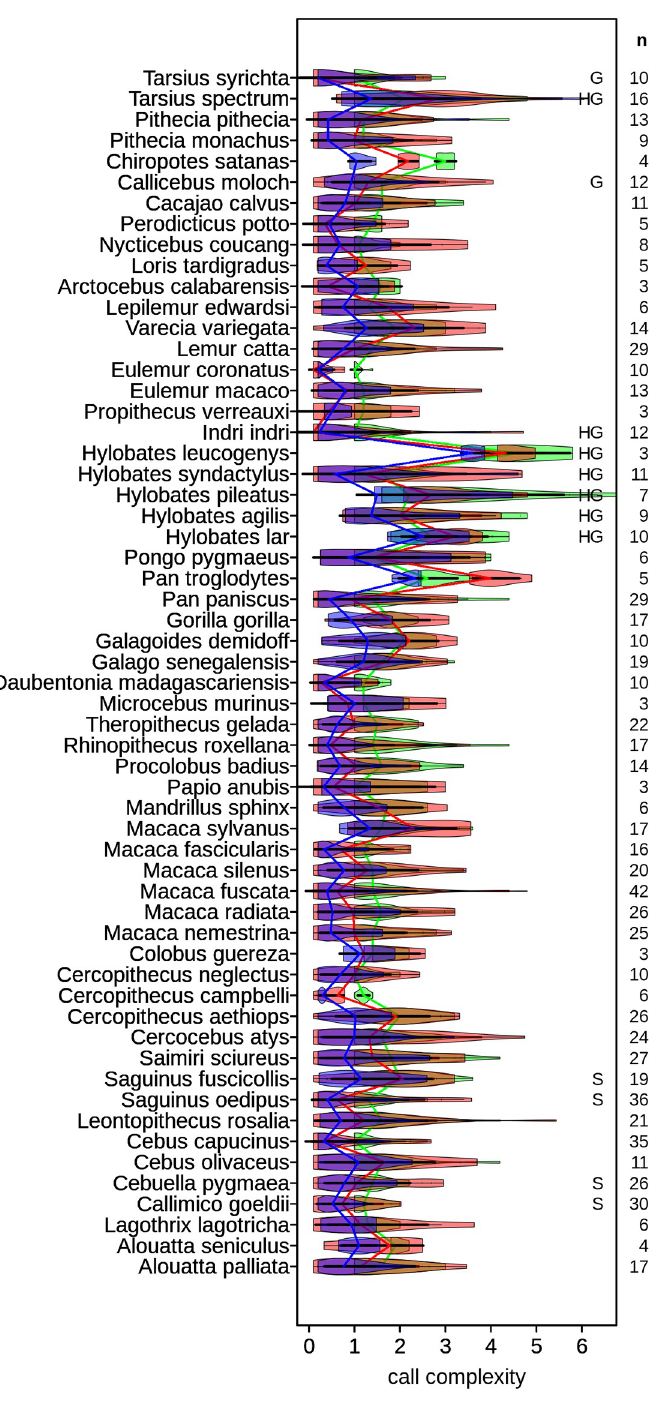
PLOS ONE | https://doi.org/10.1371/journal.pone.0218006 December17,